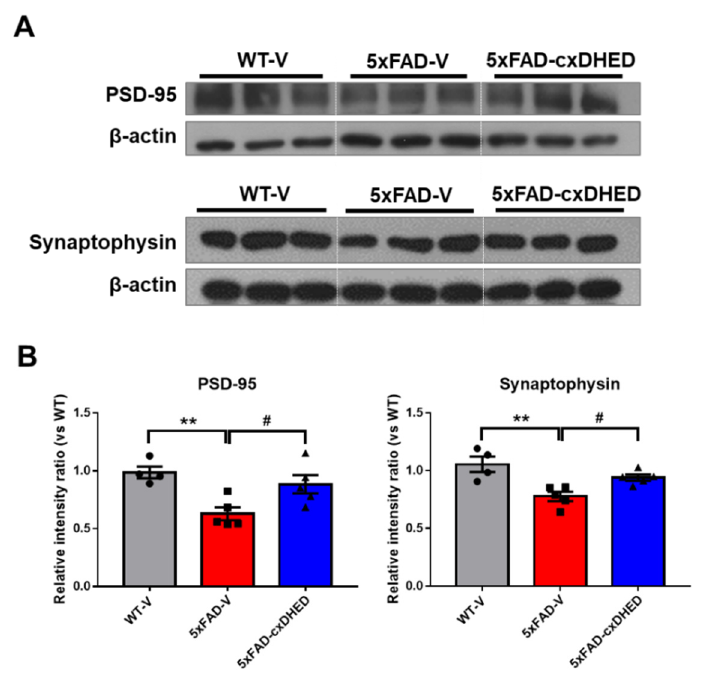
Figure 6. cx-DHED treatment alleviated loss of synaptic protein in the brain of 5xFAD mice. ( A ) The expression levels of PSD-95, a postsynaptic marker, and synaptophysin, presynaptic markers, were analyzed in the fraction of synaptic protein in the brain of mice. ( B ) Quantified values of PSD-95 and synaptophysin are expressed as the mean ± SEM (WT-V; n = 4, 5xFAD; n = 5, 5xFAD-cx-DHED; n = 5). β -actin was used as a loading control. ** p < 0.011 vs. WT-V group, # p < 0.05 vs. 5xFAD-V group. Statistical analysis between the three groups was performed using the one-way analysis of variance, followed by Turkey’s post hoc test.